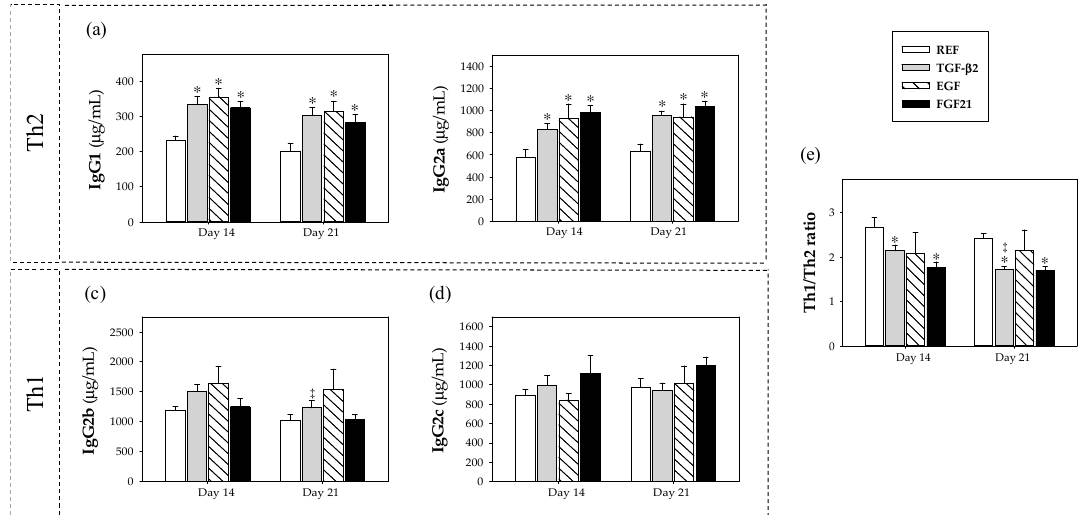
Figure 2. Effect of growth factor supplementation on plasma IgG isotypes from the four groups, i.e., reference (REF), transforming growth factor- β 2 (TGF- β 2), epidermal growth factor (EGF) and fibroblast growth factor 21 (FGF21), over the suckling period (day 14 and 21). ( a ) IgG1, ( b ) IgG2a, ( c ) IgG2b, ( d ) IgG2c and ( e ) Th1/Th2 antibody pattern ratio. Values ( μ g/mL) are represented as means ± S.E.M. ( n = 9 pups per group). Statistical differences: * p < 0.05 vs. REF group, ‡ p < 0.05 vs . same group at day 14.